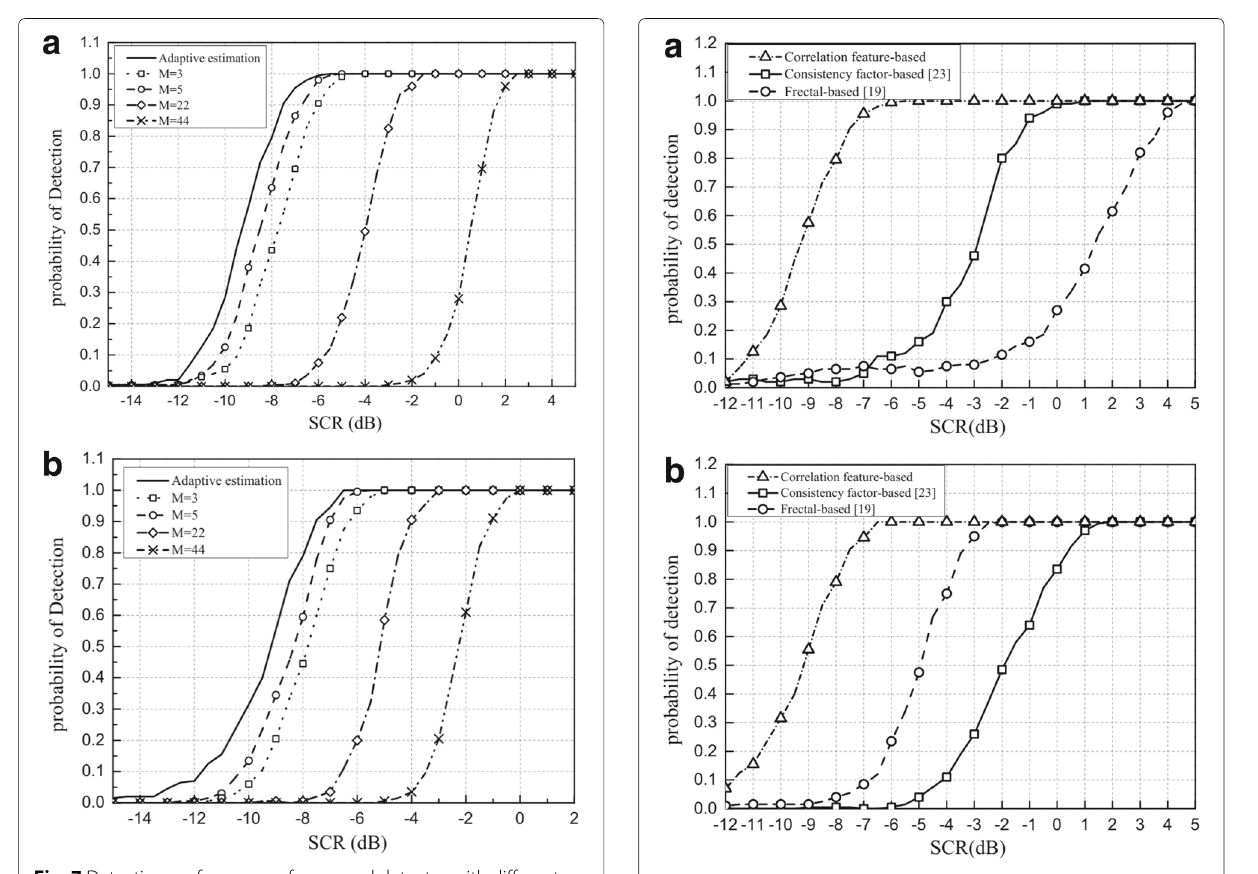
N = 128 is very close to that for N = 256 and is supe- rior to that for N = 512. For target 2, the performance